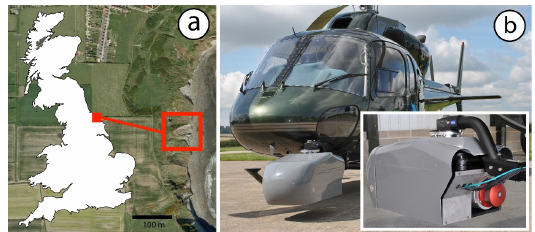
Figure 1: Airborne system and the study area